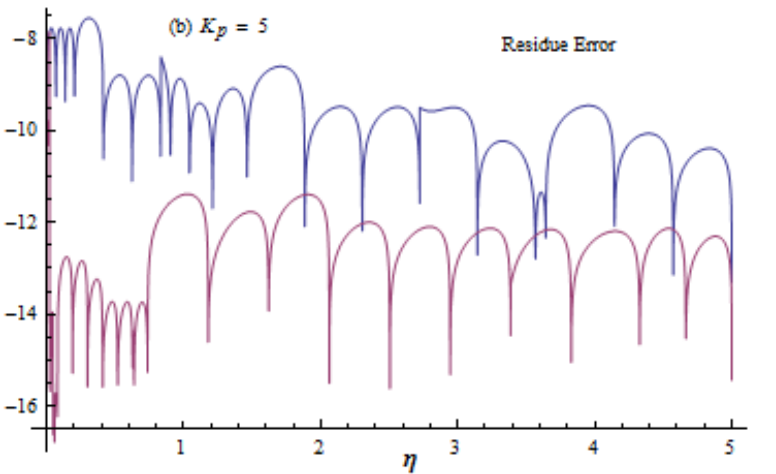
Figure 4. Error ( a ) and residue error ( b ) for 𝐾 𝑝 = 5. The blue line represents the average residue error and the red line represent the total average residue error in ( b ).